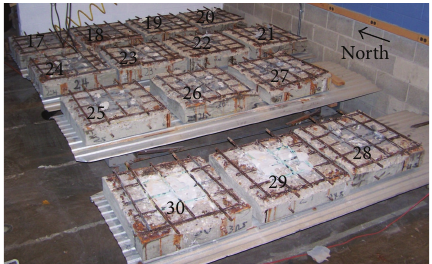
Figure 11: Dissected laboratory CoC